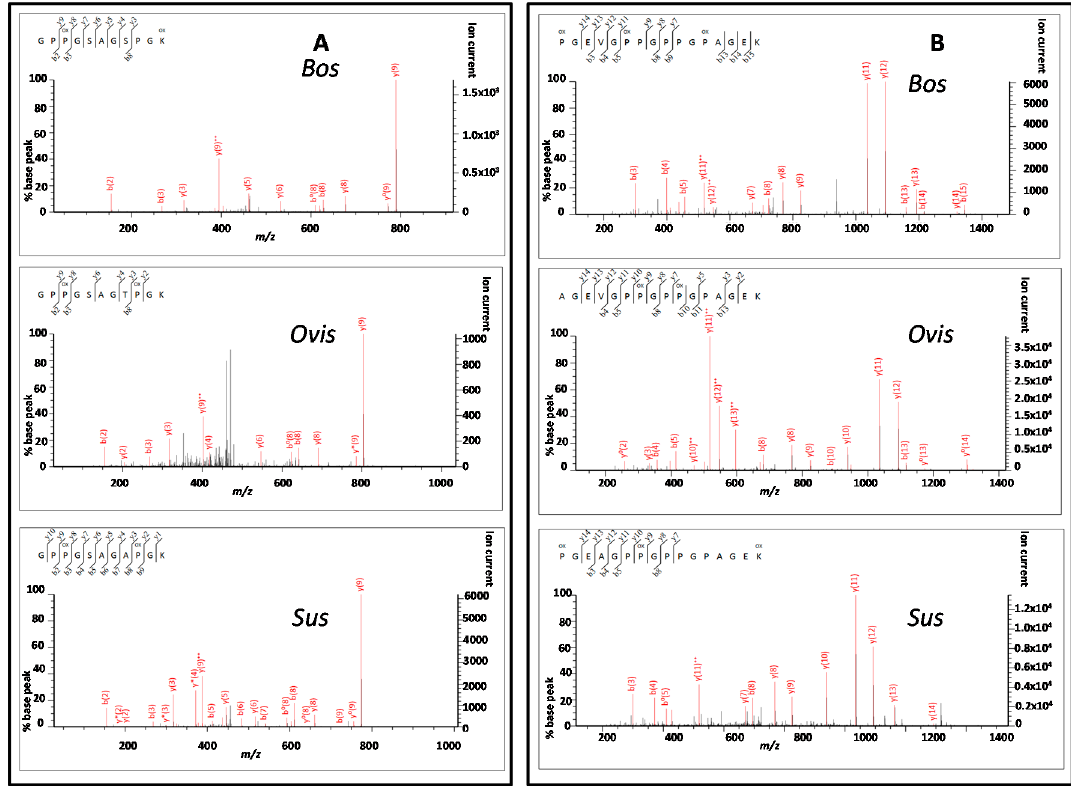
Figure 4. Tandem mass spectra of the two highest scoring α 1(I) chain peptides that are unique to each taxa within this study showing peptides: ( A ) 1t67; and ( B ) 1t86.